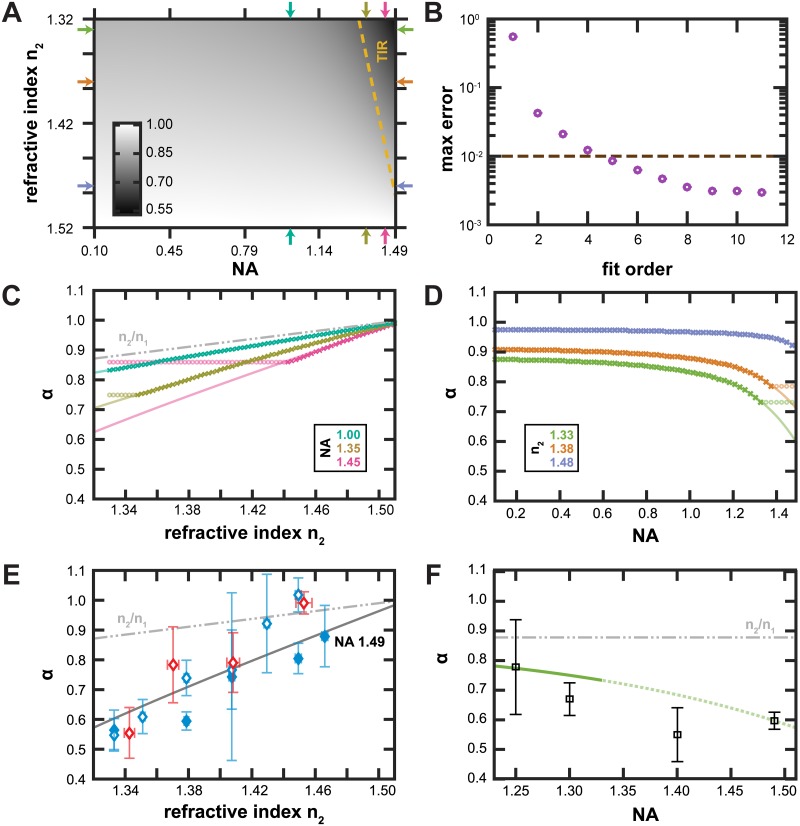
Polynomial extrapolation of relative focal shift as a function of NA and n
2.(A) α
poly as a function of NA and n
2. The colormap (inset) gives the value of α. The TIR region is marked by a dashed gold line. Colored arrowheads indicate where the 1D slices through this surface are taken for panels C and D. (B) The order of the polynomial extrapolation is chosen as the lowest order whose maximal error (grape) is less than the maximal difference between α
646 and α
489 (cocoa). (C-D) α evaluated by the theory in [2] at various values of NA and n
2 (symbols) along with the global fit to Eq 3 (lines). Symbols that corresponding to TIR systems are shown as faded circles. (C) α as a function of refractive index for three different values of numerical aperture (1.00 in turquoise, 1.38 in olive, 1.48 in orchid). Also included is the n
2/n
1 approximation (gray—⋅⋅). (D) α as a function of numerical aperture for three different values of n
2 (1.33 in pistachio, 1.38 in goldenrod, 1.43 in periwinkle). (E) Experimentally observed α for imaging system of varying refractive index. Refractive index of the medium was increased by including glycerol (cornflower) or sucrose (dark red). Two copies of the same model of objective were measured, results from one are filled symbols and the other are open. Evaluating the α
poly with an NA of 1.49 is shown in charcoal. α error bars are 90% CI. n
2 error bars reflect changes in additive concentration by ± 1.5%. (F) Experimentally observed α
multiBead as a function of NA for imaging systems with various objectives using the multiple bead sizes method.